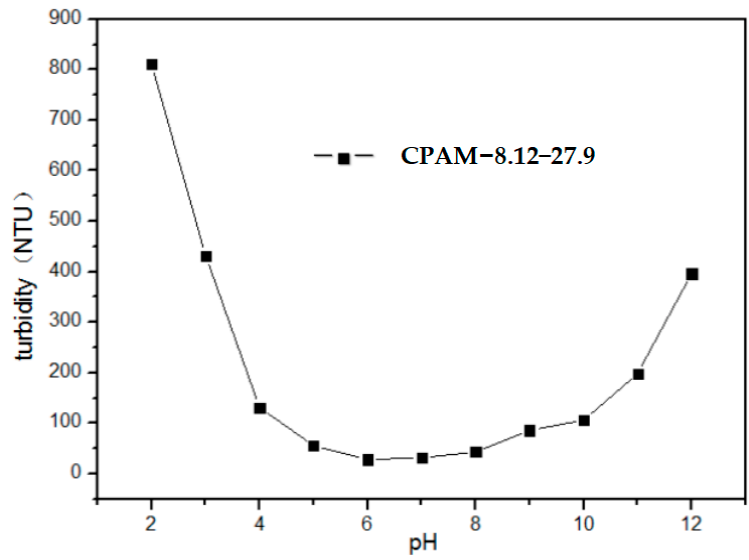
Figure 2. Impact of wastewater pH on the flocculation effect of CPAM.